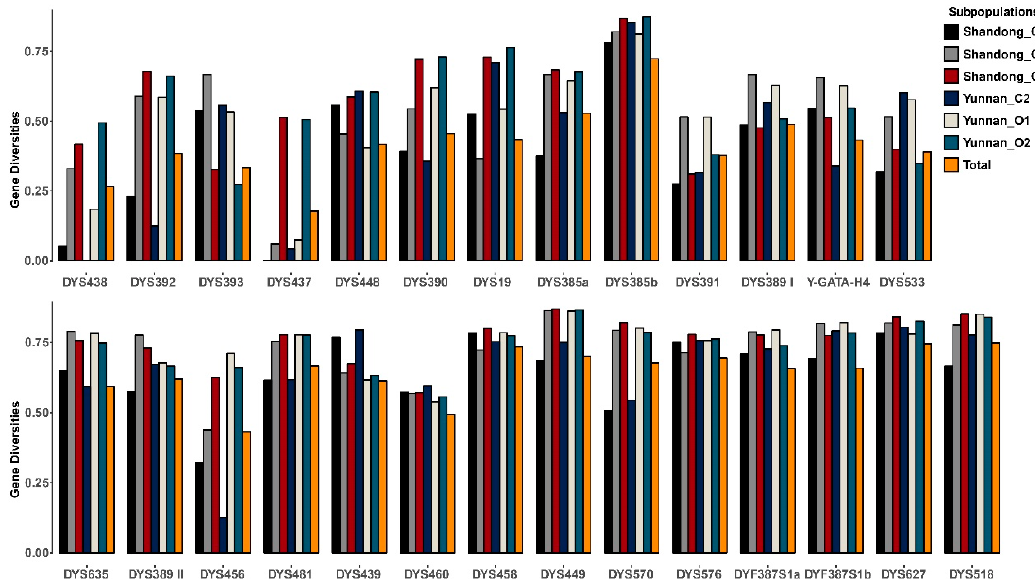
Figure 5. Gene diversity values for the 27 Y-STR markers in di ff erent major Y-chromosomal haplogroups. The bar colors indicate the gene diversity (GD) values in di ff erent major Y haplogroups (C2, O1, and O2) of each population and in all 870 samples. The order of Y-STR markers is arranged along with Y-STR mutability (from low to high) [4].